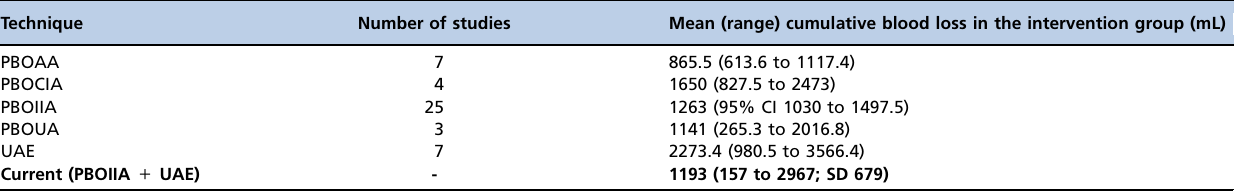
PBOAA: prophylactic balloon occlusion of the abdominal aorta; PBOCIA: prophylactic balloon occlusion of the common iliac arteries; PBOIIA: prophylactic balloon occlusion of the internal iliac arteries; PBOUA: prophylactic balloon occlusion of the uterine arteries; UAE: uterine arteries embolization; mL: milliliters. *extracted and adapted from Shahin and Pang, 2018